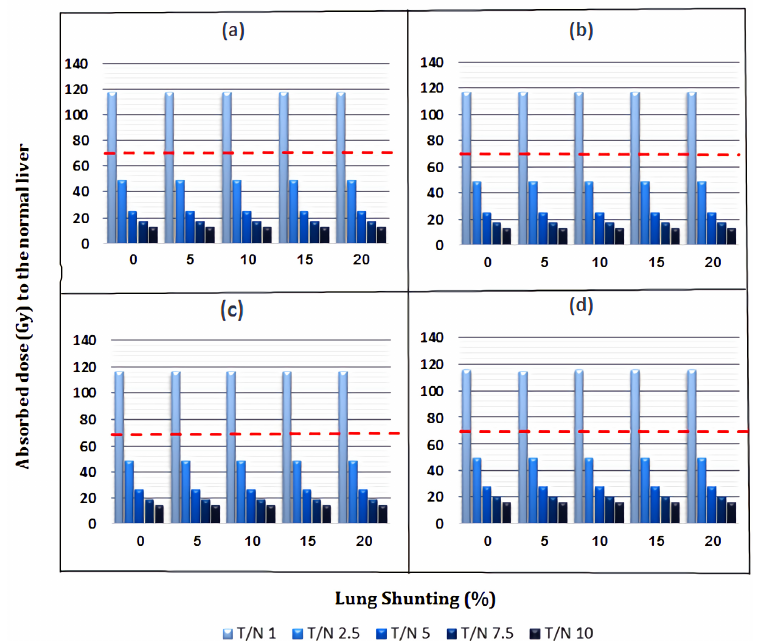
Figure 6. Absorbed dose to the normal liver for various TIs of ( a ) 10, ( b ) 30, ( c ) 50, and ( d ) 70%, LS, and T/N, when 120 Gy is delivered to the tumour. The red dotted lines represent the maximum dose limit of 70 Gy for a normal liver.